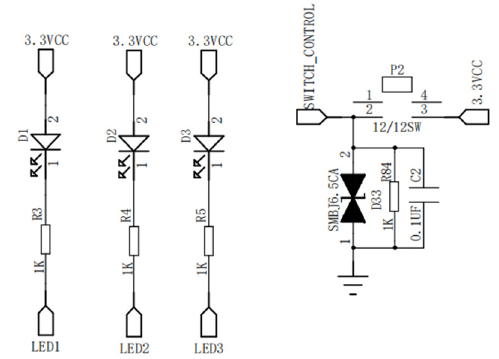
Figure 5. Schematic diagram of the button control module.